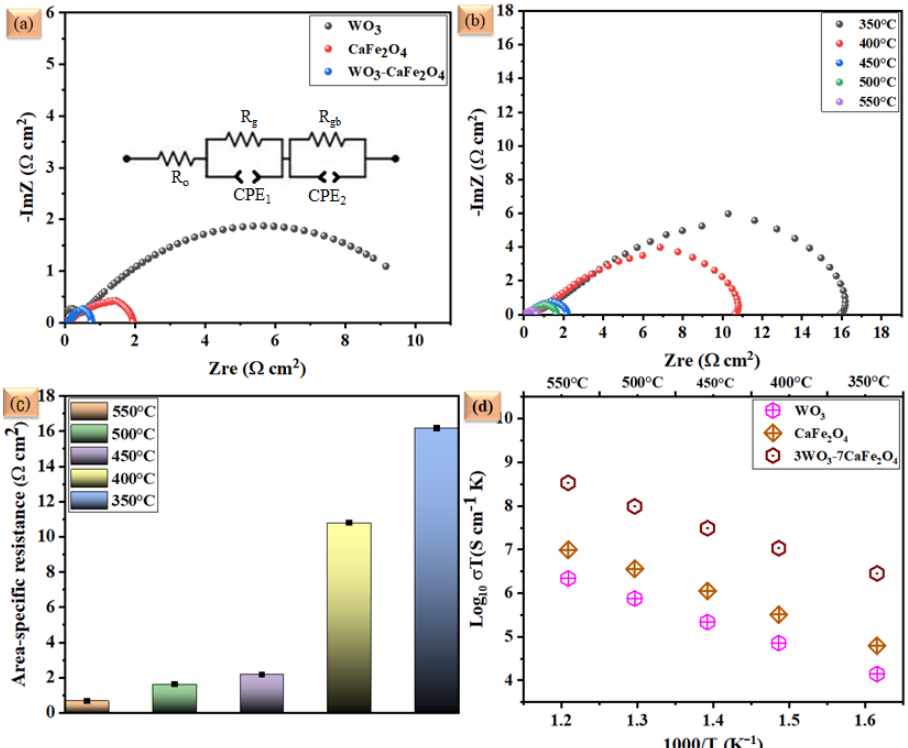
Figure 4. ( a ) Nyquist plot of Impedance spectra for symmetrical electrode cell based on pure CaFe 2 O 4 , WO 3, and WO 3 (cid:3398) CaFe 2 O 4 over GDC electrolyte at 550 °C, ( b ) Nyquist plot of